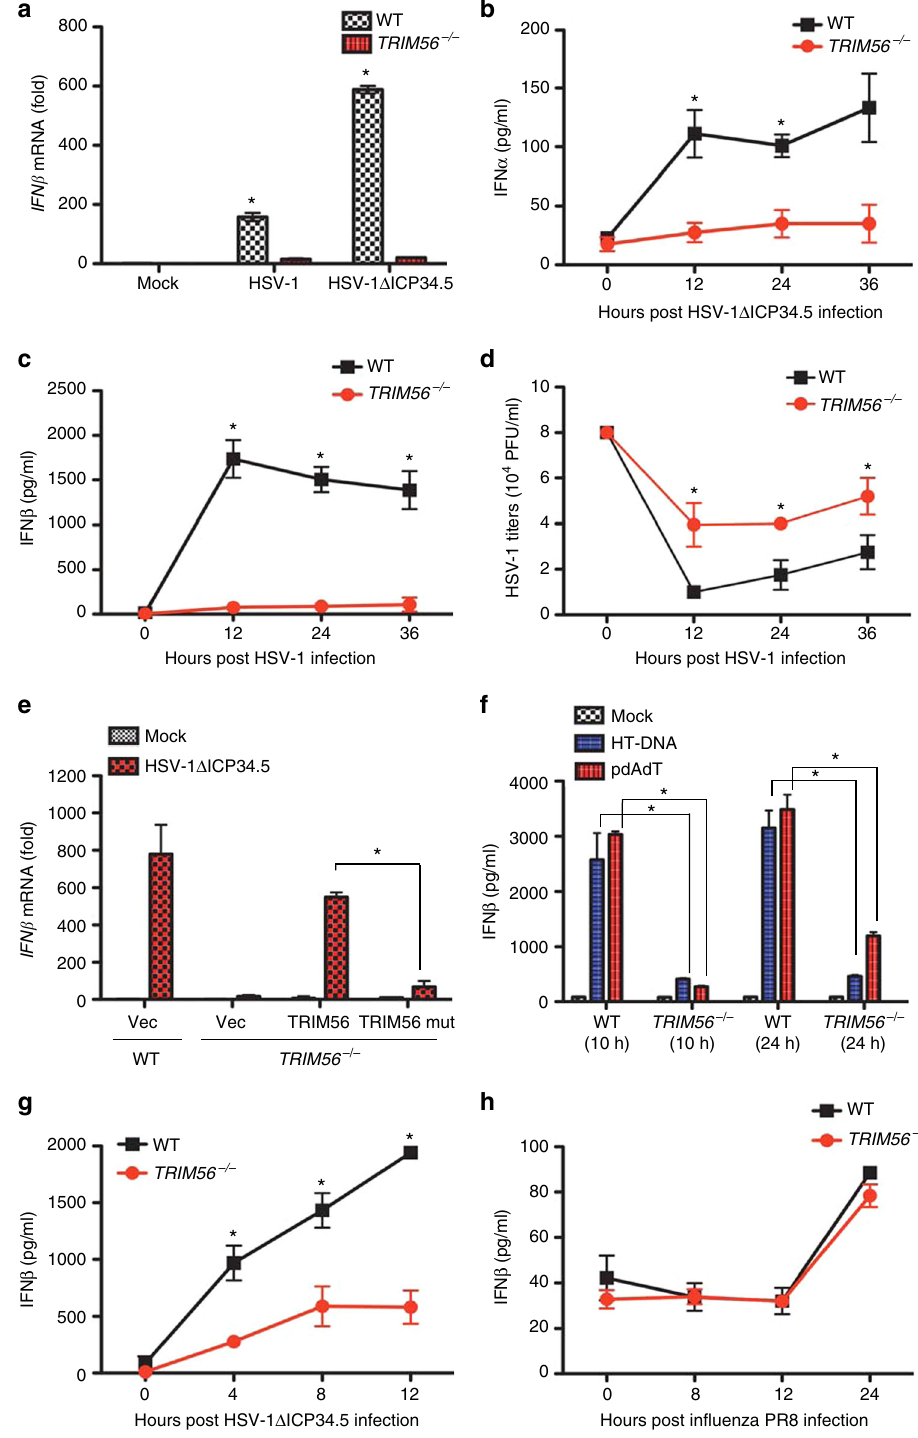
Fig. 6 TRIM56 is required for IFN induction in response to HSV-1 infection but not to IAV infection in primary cells. a RT-PCR analysis of IFN β mRNA in BMDMs from WT and TRIM56 − / − mice at 18 h after mock, HSV-1, or HSV-1 Δ ICP34.5 infection. ELISA of IFN α ( b ) or IFN β ( c ) in BMDMs from WT and TRIM56 − / − mice at the indicated time points after HSV-1 Δ ICP34.5 or HSV-1 infection. d WT or TRIM56 − / − BMDMs were infected with HSV-1 (MOI = 0.1). Viral supernatants were collected at the indicated time points, and virus titers were determined using a plaque assay on Vero cells. e RT-PCR analysis of IFN β mRNA in WT or TRIM56 − / − BMDMs infected with lentivirus-derived vector, TRIM56 WT, or TRIM56 Mut. Results are presented relative to empty vector-expressing and mock-infected WT cells. f ELISA of IFN β in MEFs from WT and TRIM56 − / − embryos. MEFs were stimulated with HT- DNA (2 μ g/ ml) or polydA:dT (1 μ g/ml). g ELISA of IFN β in BMDCs from WT and TRIM56 − / − mice at the indicated time points following infection with HSV-1 Δ ICP34.5. h ELISA of IFN β in BMDMs from WT and TRIM56 − / − mice at the indicated time points following infection with IAV PR8. Data in a – g are representative of three independent experiments. Data in h are representative of two independent experiments. Error bars in a – h indicate mean ± s.d. of n = 3. * P < 0.05 versus control using Student ’ s t -test ( a – h